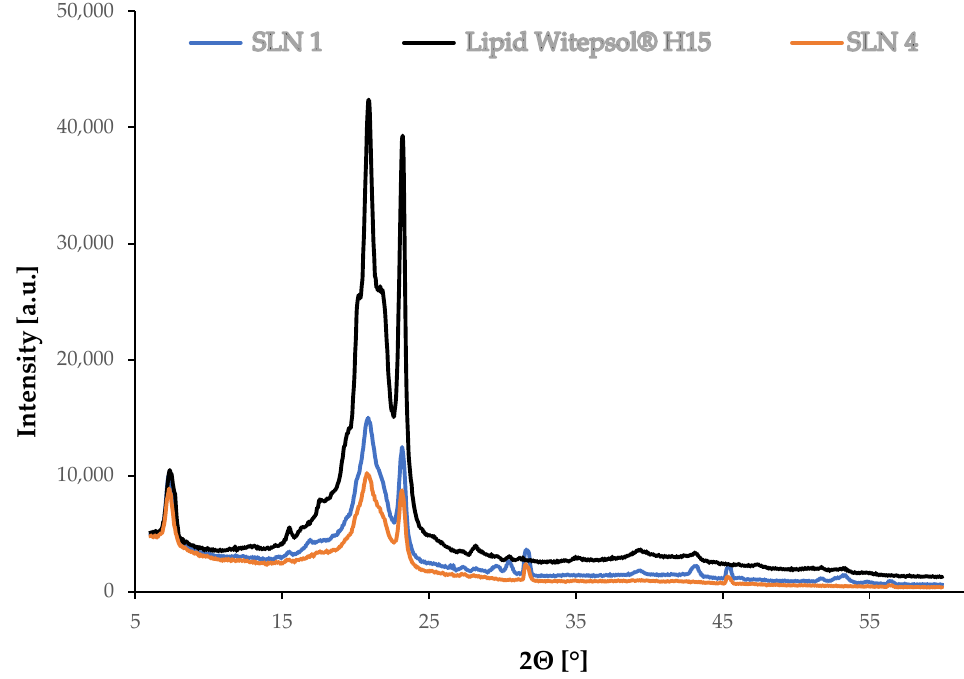
Figure 5. Diffractograms for synthesized SLNs: “empty” (without extract, SLN1), incorporated with Ferula assa-foetida L. extract (SLN4) and Witepsol ® H15 lipid.